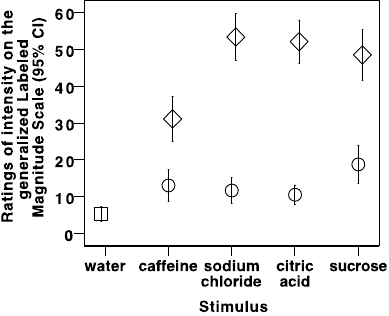
Figure 1. Ratings of intensity on the generalized Labeled Magnitude Scale for each stimulus, by low (circle) and high (diamond)